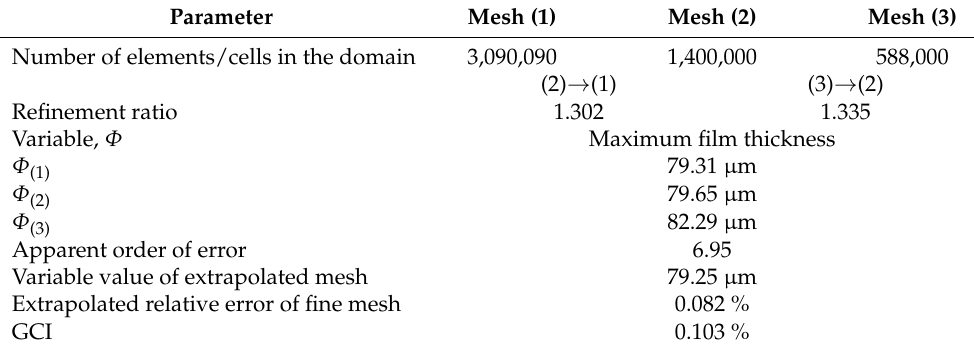
Table 3. Variable and respective values considered for the GCI analysis and calculated discretization error.